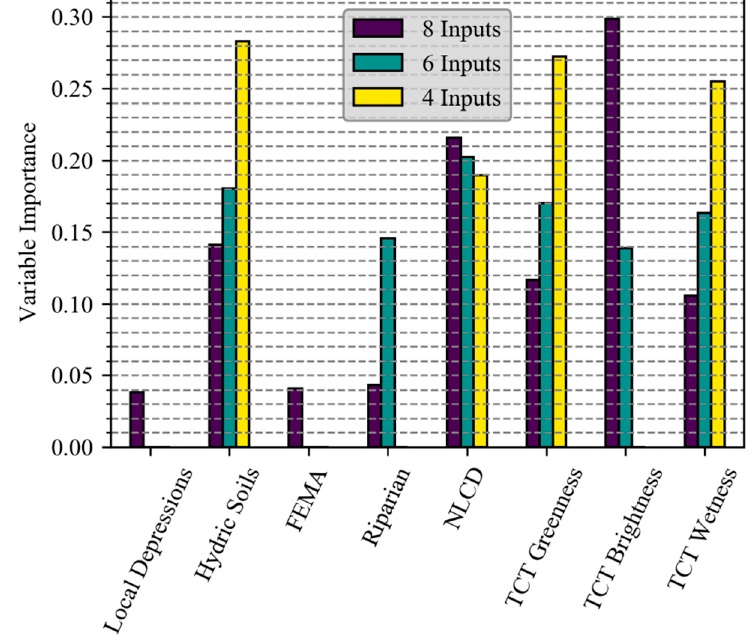
Figure 7. Variable importance reported for the three classification iterations: (1) using all eight input datasets; (2) using the top six input datasets from (1); and (3) using the top four input datasets from (2).